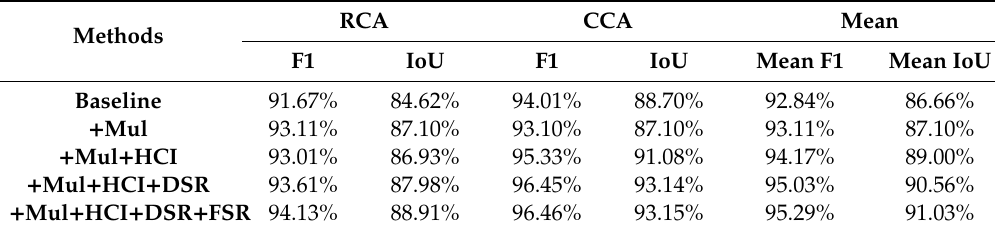
Table5. QuantitativecomparisonfortheablationexperimentsonourproposedHCNet. ‘Mul’represents aggregating the multi-scale information in the commonly used direct stacking way. ‘Mul + HCI’ represents aggregating the multi-scale information in our proposed hierarchical cascade way. ‘Mul + HCI + DIR’ represents aggregating the multi-scale information by using our proposed hierarchical cascade method and adding the detailed structure refinement strategy. ‘Mul + HCI + DIR + FSR’